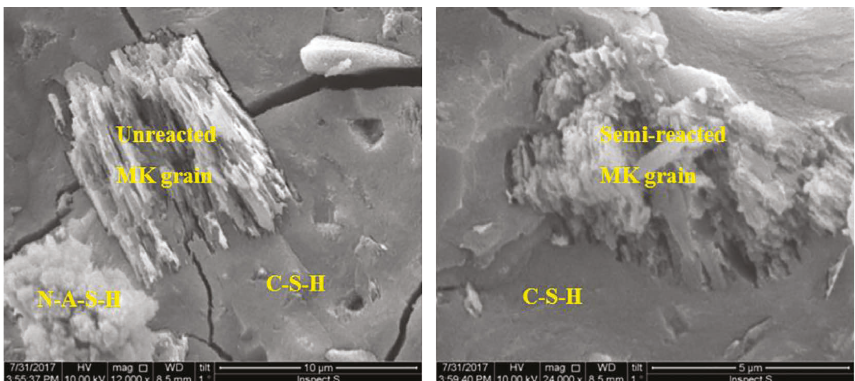
Figure 11: The SEM images for 85GMS geopolymer paste at 7 curing days.